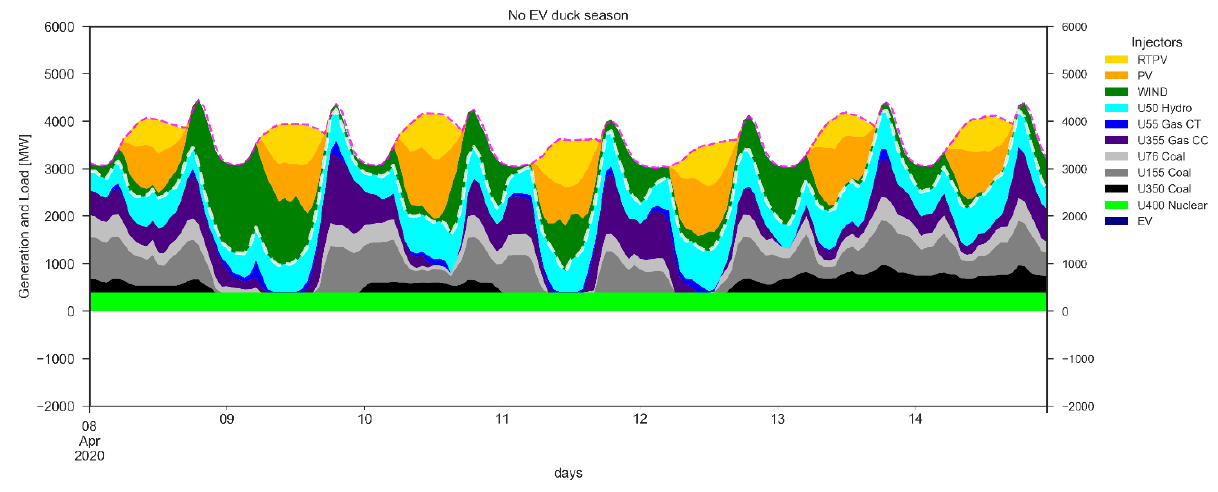
Figure 6. The generation stack for Duck week in April, assuming no EV charging.